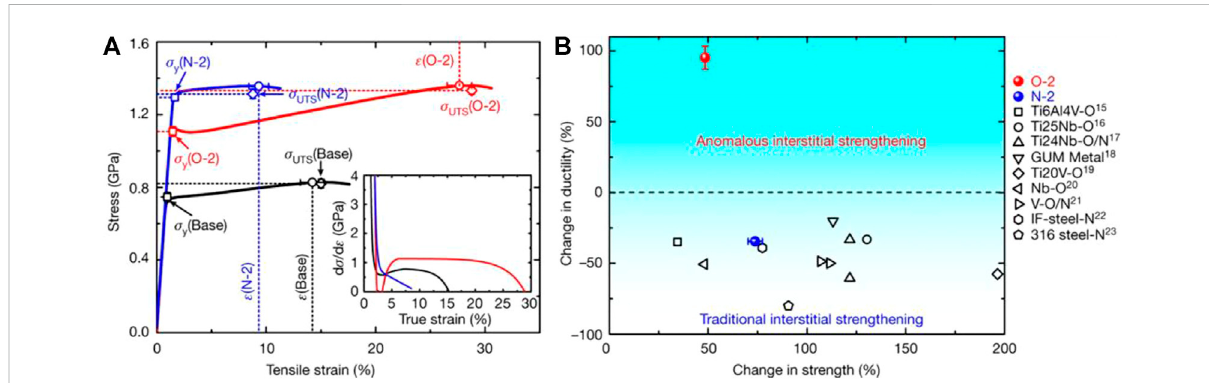
FIGURE 16 (A) Room-temperature tensile stress-strain curves for TiZrHfNb (TiZrHfNb) 98 O 2 , and (TiZrHfNb) 98 N 2 HEA. The inset shows the corresponding strain-hardening response (d σ /d ε ) (B) Variation in strength and ductility of the HEA presented here, relative to several established high-performance alloys (Lei et al.,